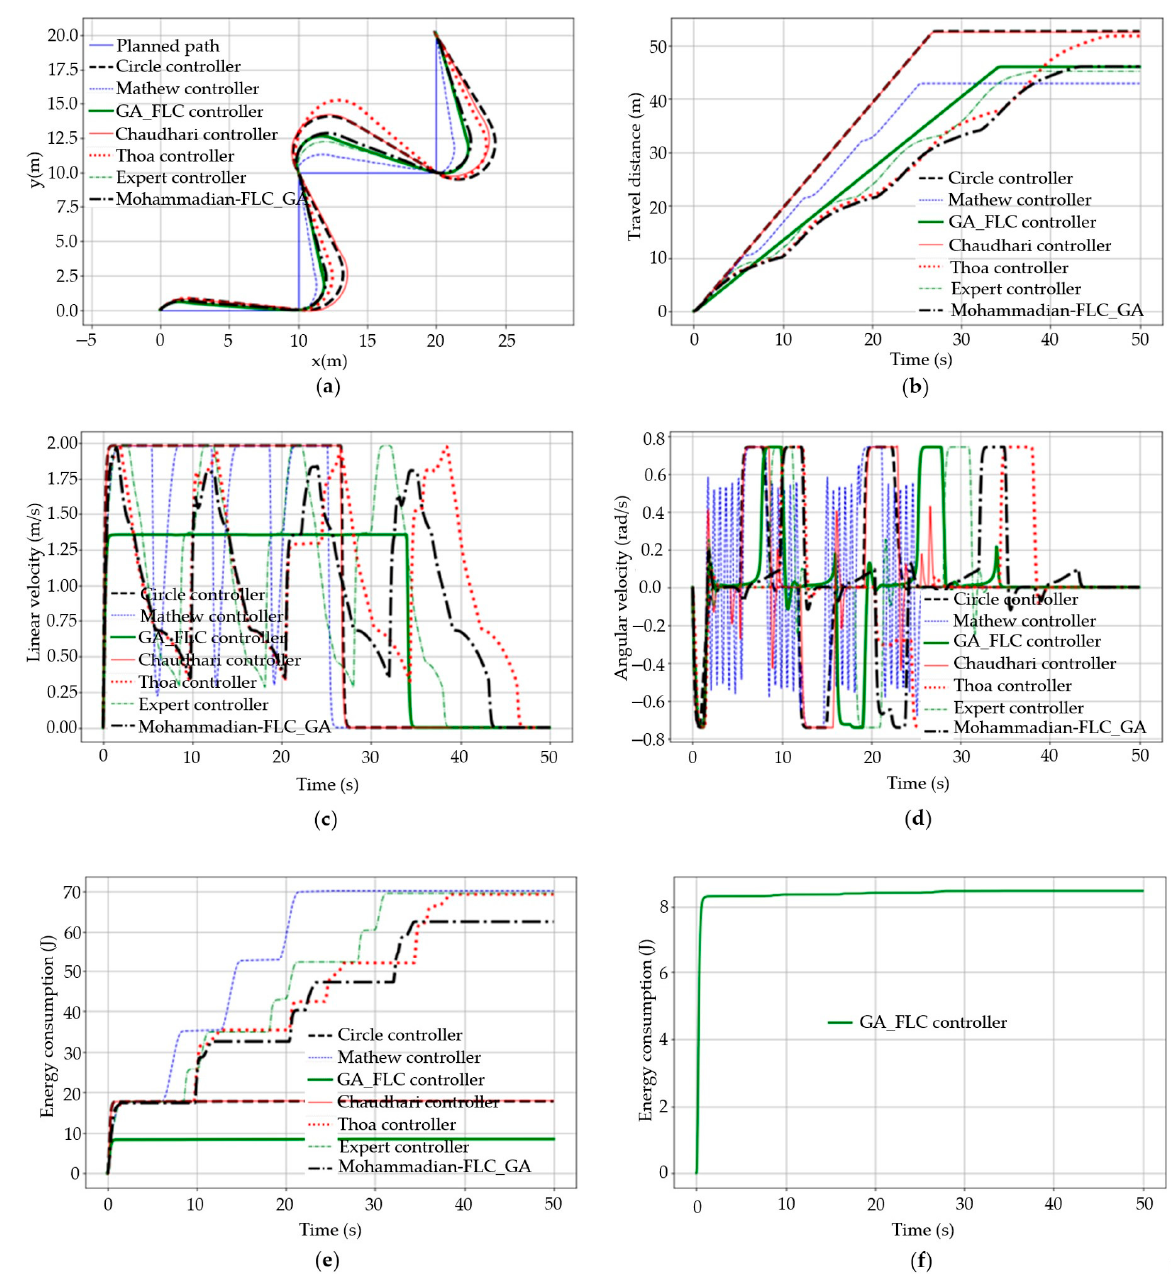
Figure 13. Analysis of the simulation results for the zigzag path. ( a ) The zigzag path tracking of the robot; ( b ) The robot’s travel distance over time when the robot tracks the zigzag path; ( c ) The robot’s linear velocity over time when the robot tracks the zigzag path; ( d ) The robot’s angular velocity over time when the robot tracks the zigzag path; ( e ) The robot’s kinetic energy loss over time when the robot tracks the zigzag path; ( f ) The zoom of the robot’s kinetic energy loss over time when the robot tracks the zigzag path.